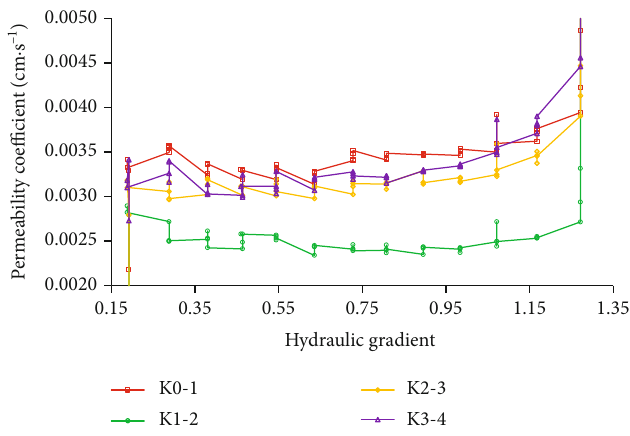
Figure 10: Process curve between hydraulic gradient and permeability of di ff erent parts in soil numbered F.